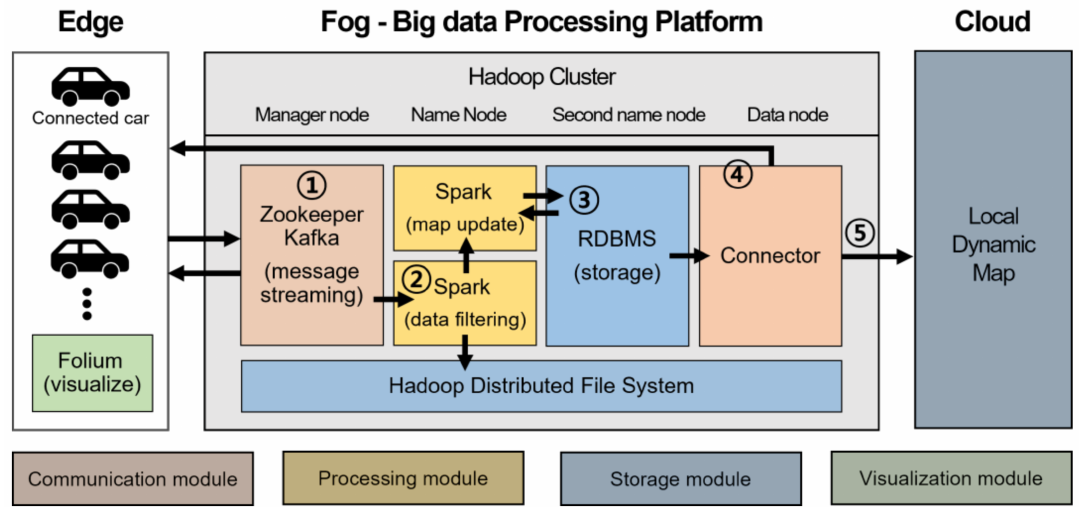
Figure 7. Processing procedures for submodules of big data